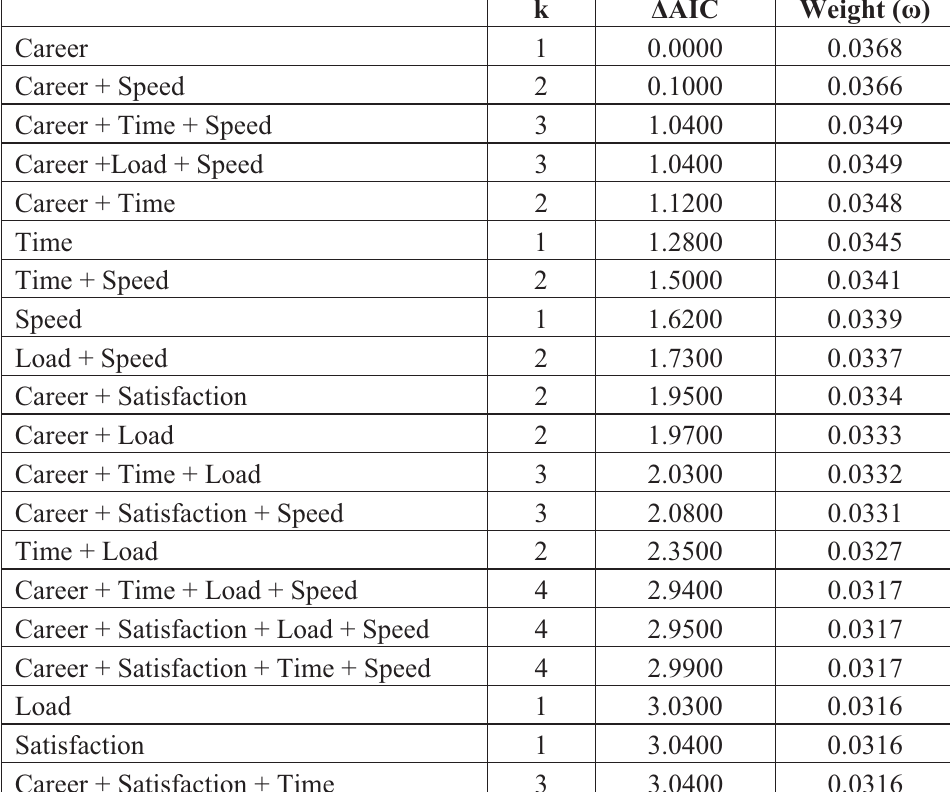
Table 2. Any hand pain results (k = number of